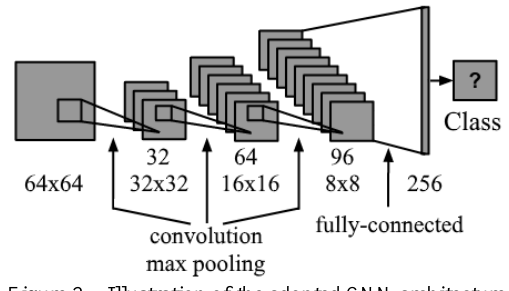
Figure 2 – Illustration of the adopted CNN architecture.